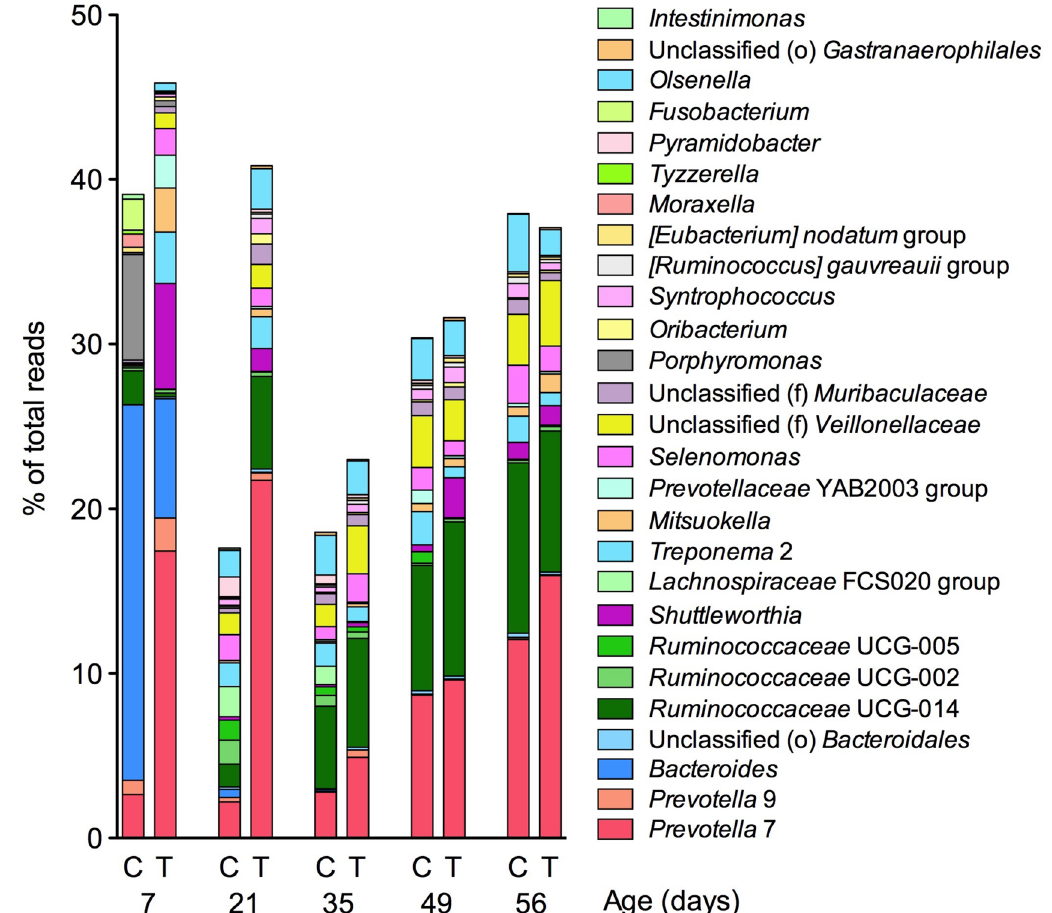
Figure 3. Change in the relative abundance of bacterial genera determined via amplicon sequencing. Bacterial genera showing > 0.1% relative abundances and significantly affected by the diet effect were selected from Supplementary Table S3, and the difference between the control and treatment groups at each sampling point were evaluated by a negative binomial model implemented as a Wald test in DESeq2 package in R software. Bacterial genera showing significant differences during at least one age point from 7 to 56 days of age are depicted in the graph. C control group, T treatment